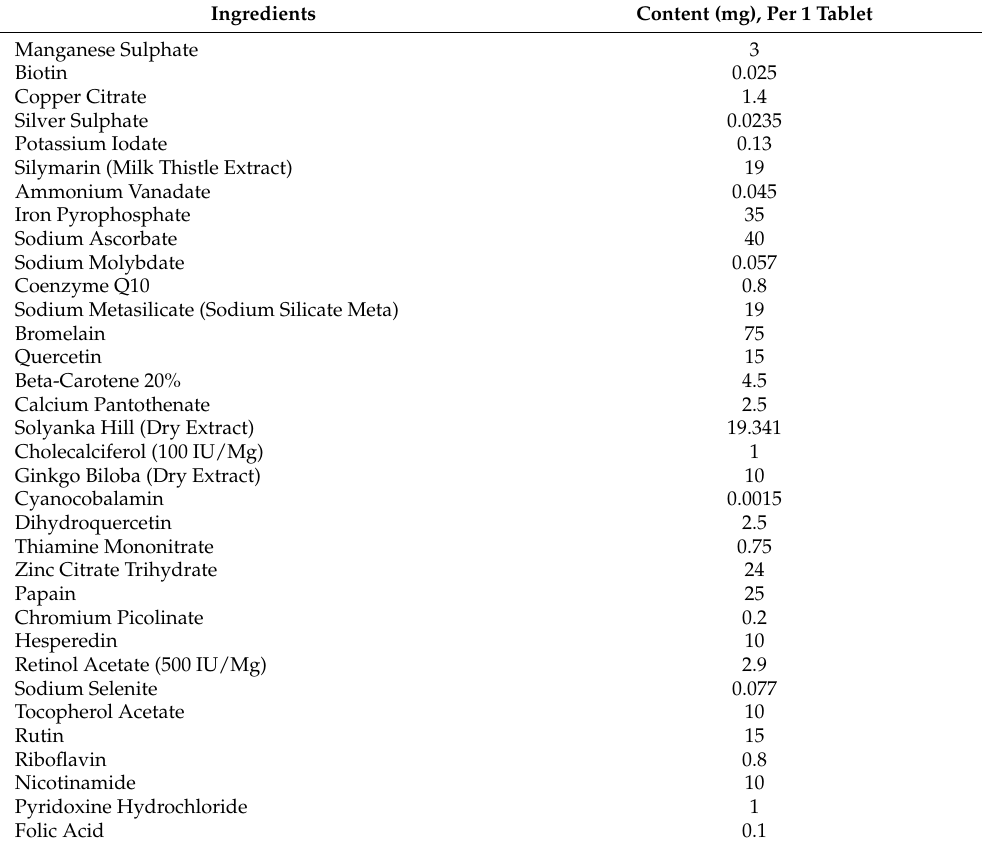
Table 1. Formula 1 ingredients.